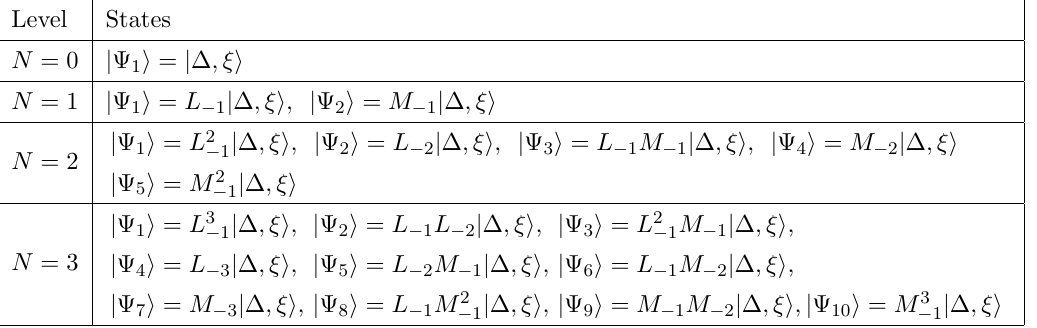
Table 1 . States in the BMS module upto level